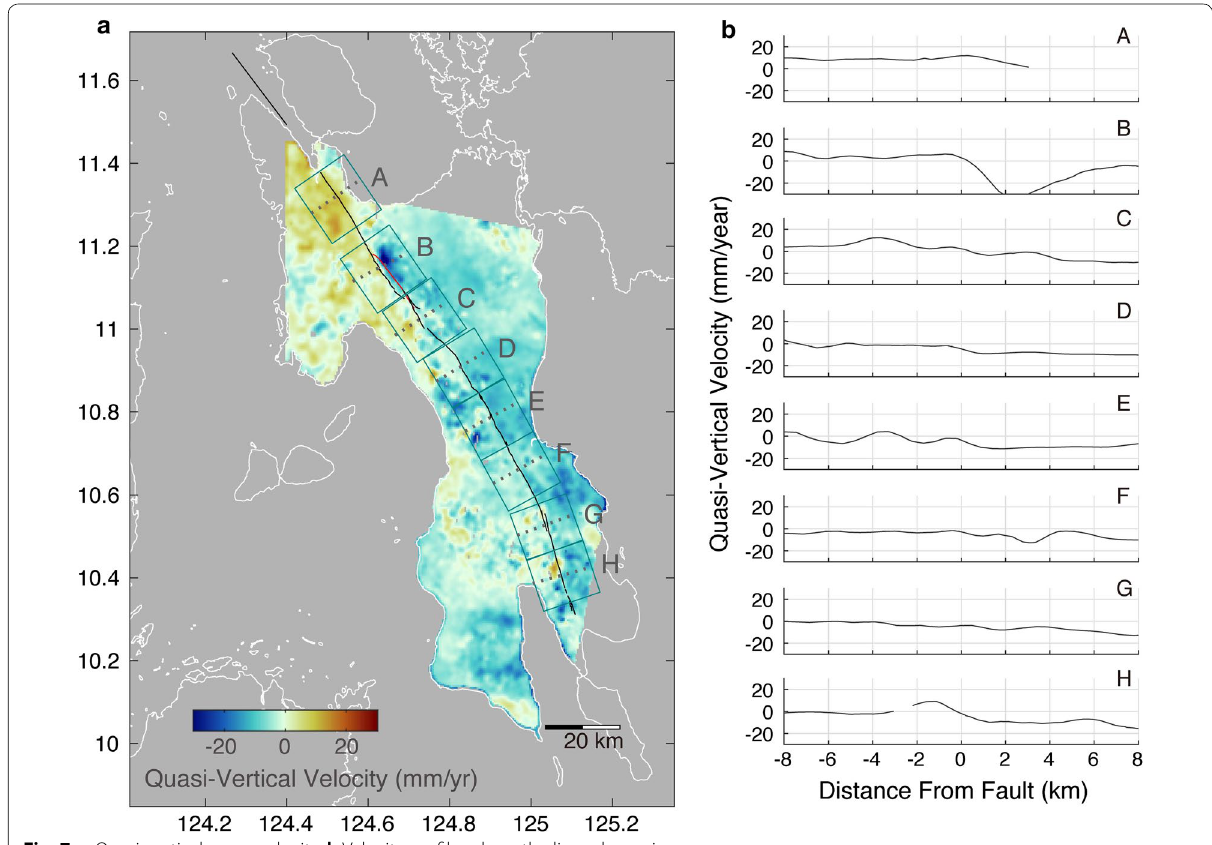
Fig. 7 a Quasi-vertical mean velocity. b Velocity profiles along the lines shown in